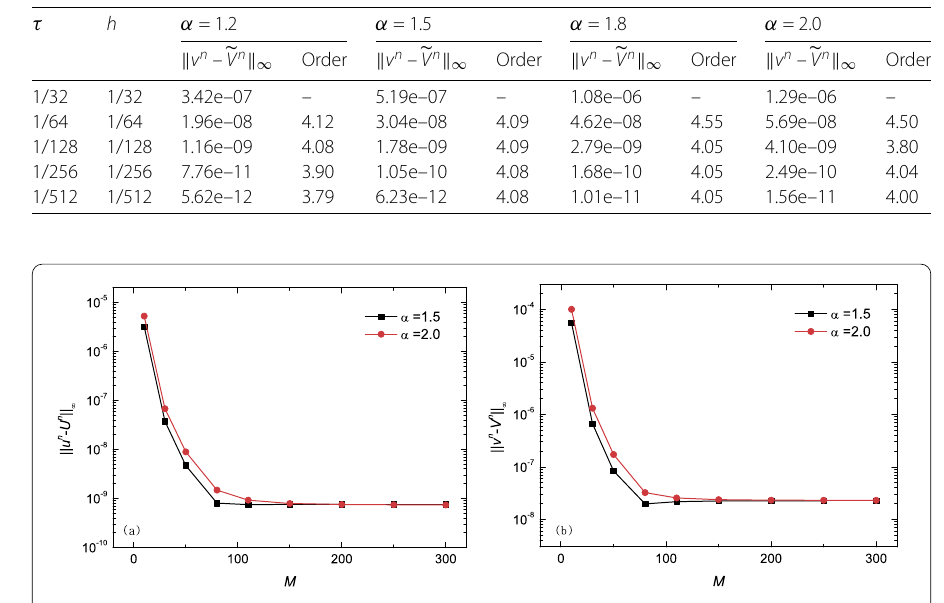
Table 2 L ∞ -norm errors and convergence orders of (cid:24) V obtained by the fourth-order scheme for Example 1